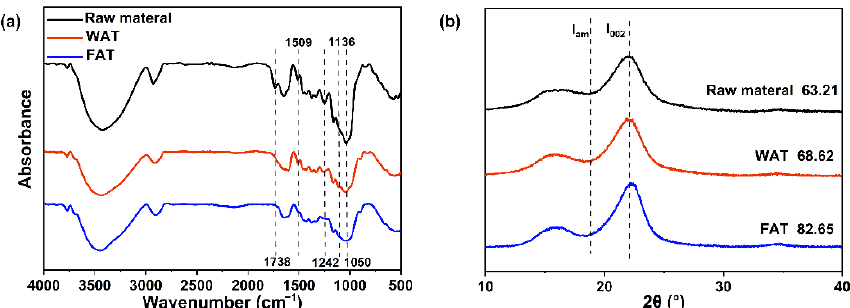
Figure 4. Changes of main functional groups and crystallinity index of bamboo with and without different treatment ( a ), Fourier transform infrared (FTIR) spectra; ( b ), X-ray diffraction (XRD) patterns; WAT, Weak alkali treatment; FAT, Freeze – thaw assisted alkali treatment).